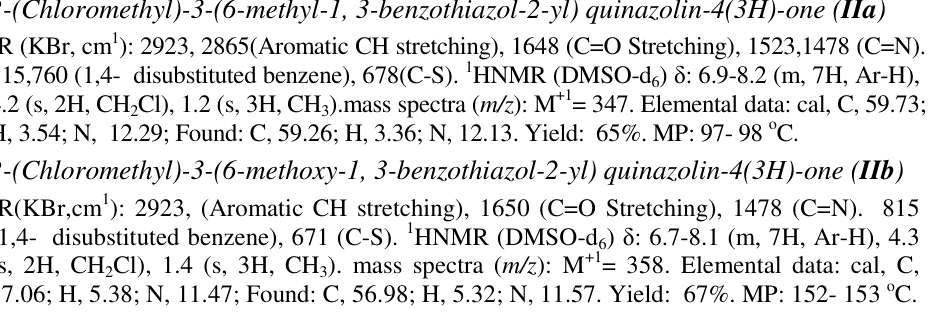
4(3H)-one ( II a-d